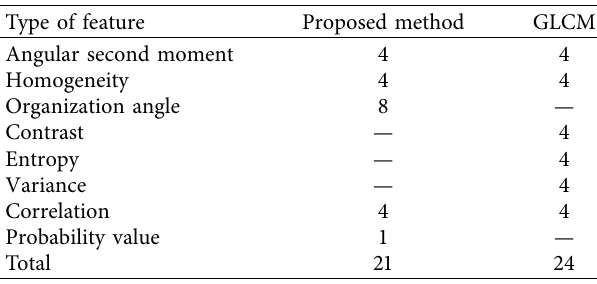
Figure 8: Examples of some different angles with 180 degrees of rotation changes of the face images in the FEI. Table 2: Types of features, proposed approach, and GLCM.